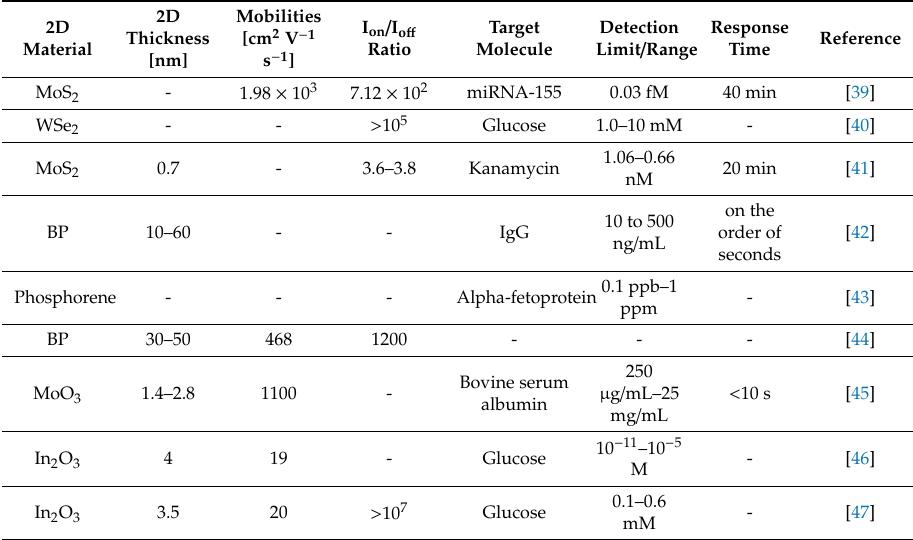
Table 1. Overview of literature reports on non-carbon 2D material-based FET biosensors.